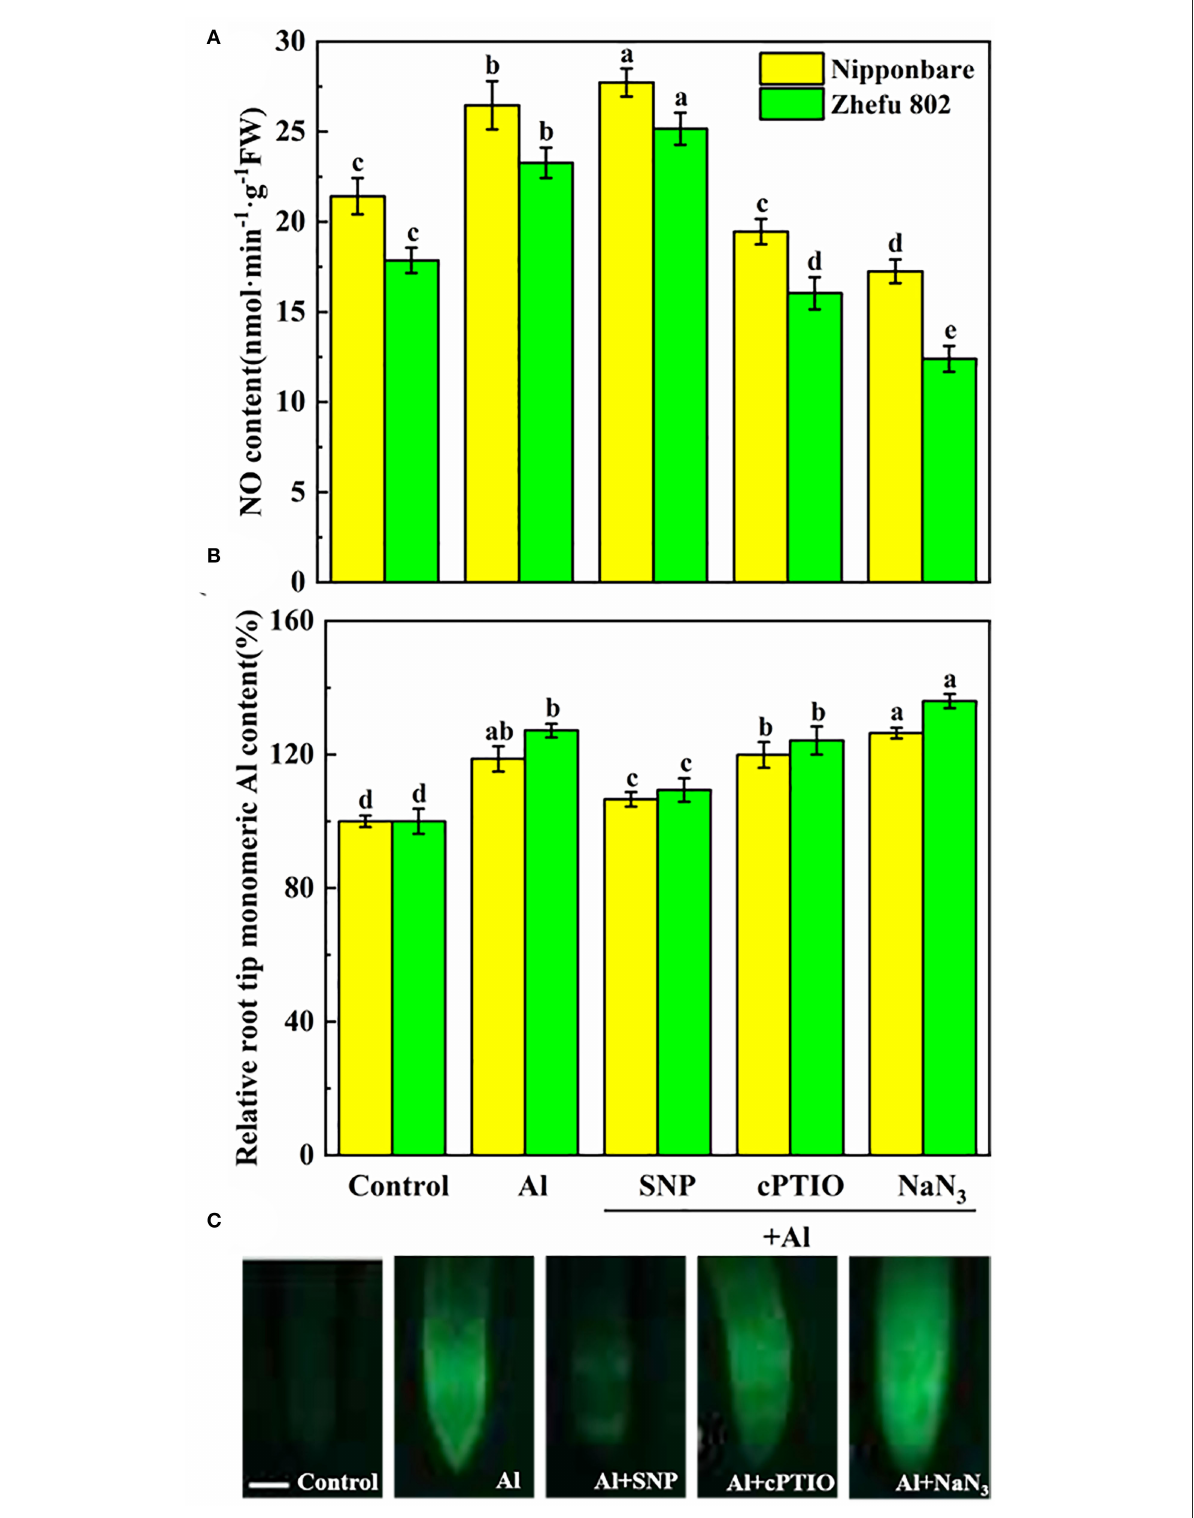
FIGURE1 Effect of Al toxicity and SNP donor on (A) endogenous NO content, (B) mononuclear Al content, and (C) Al accumulation by Morin fluorescence staining in rice root tips. Columns with different letters are significantly different at P < 0.05 . Bar in graph C indicated 200 µ m.